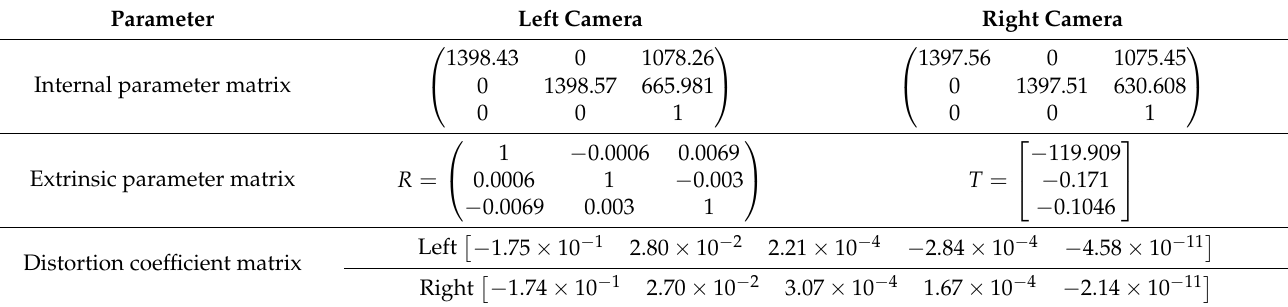
Table 5. Camera parameter